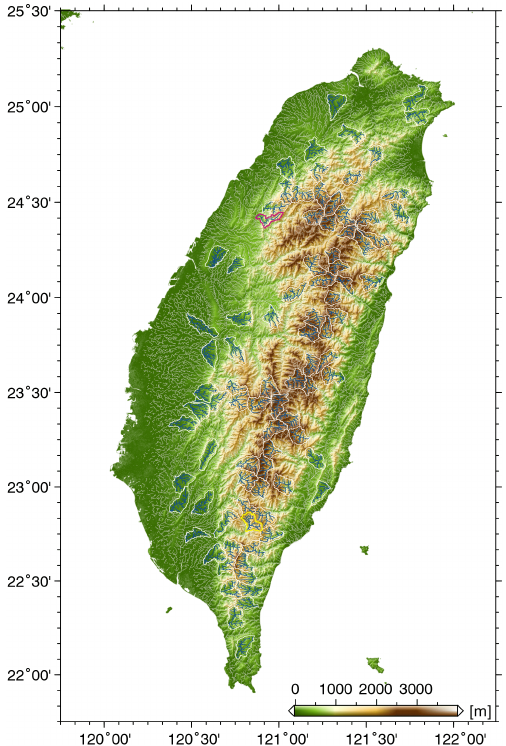
Figure 2. Map of the 89 considered catchments in Taiwan with catchment sizes A ≈ 100 km 2 . The two catchments bordered in ma- genta and yellow are considered in detail in Figs. 4–6.